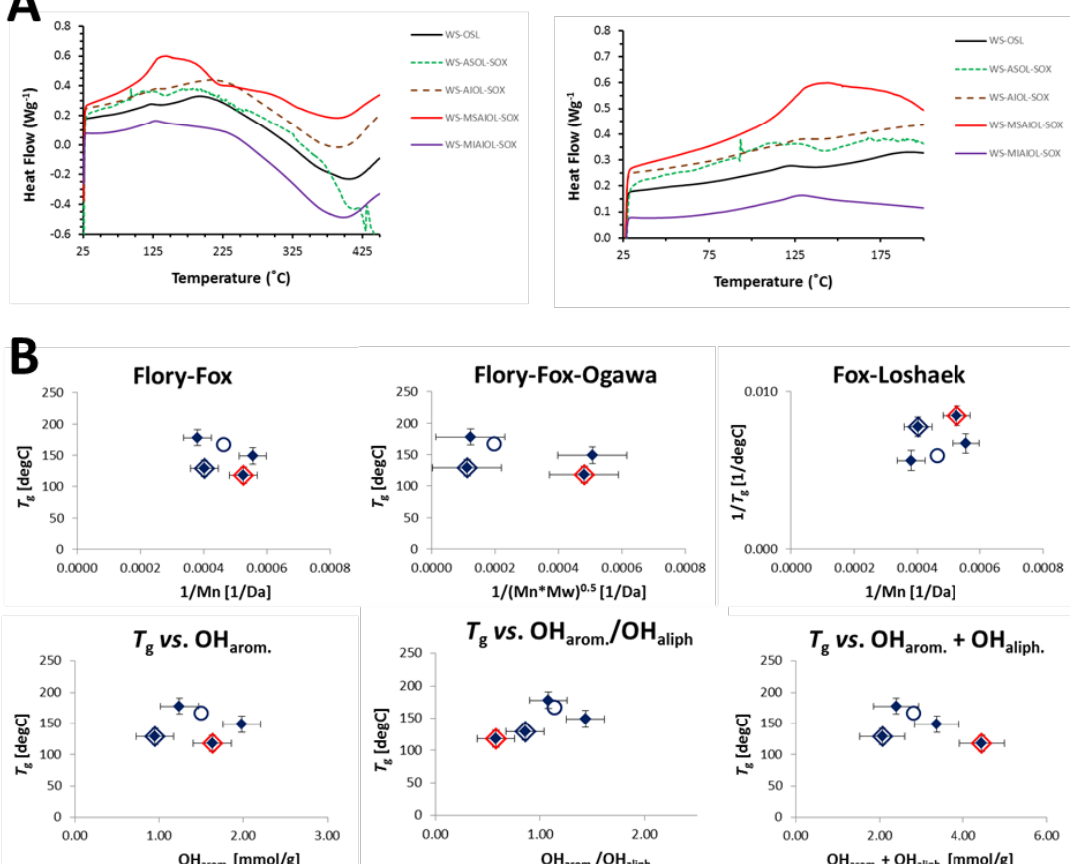
Figure 7. ( A ) Heat flow curves obtained for WS-OSL and fractions derived thereof. ( B ) Correlation of glass transition temperatures with molecular weight characteristics according to Flory–Fox, Flory–Fox–Ogawa and Fox–Loshaek theories, respectively, as well as directly with the mean average molecular weight (Mn), the total amount of phenolic OH-groups and the ratio between aromatic and aliphatic OH-groups. WS-OSL is represented by the hollow circle, WS-MSAIOL-SOX is additionally evidenced by a red rhomb, and WS-MIAIOL-SOX by a blue rhomb. Rough correlations were only found for WS-OSL and the two initial acetone fractions